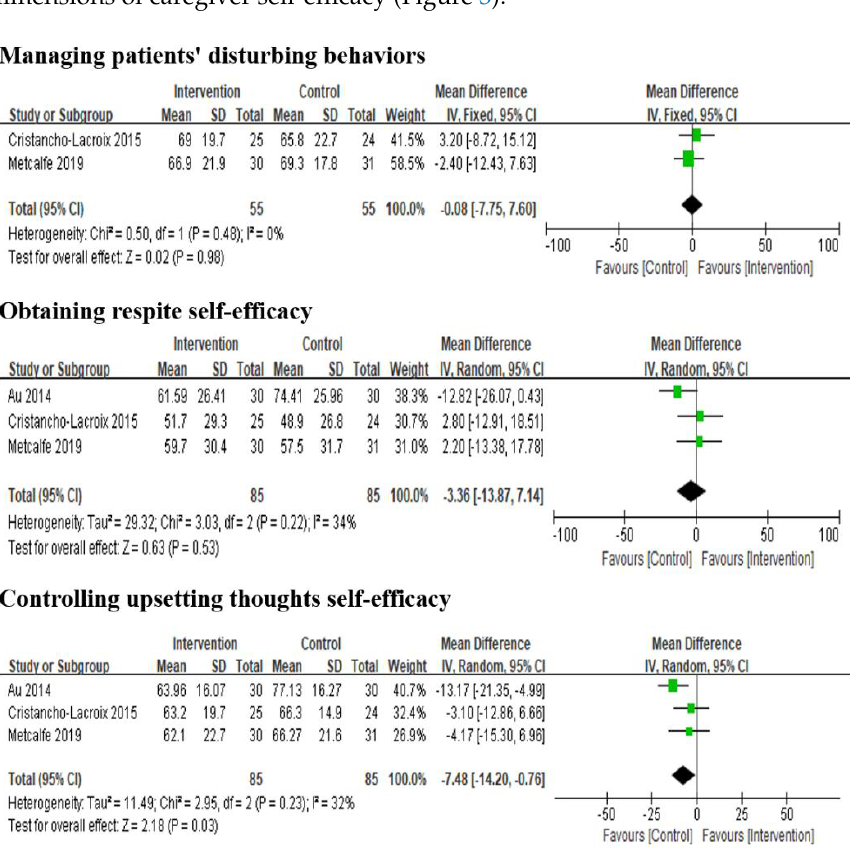
Figure 3. Effect of multi-component interventions on informal caregiver’s self-efficacy (post-inter- vention).